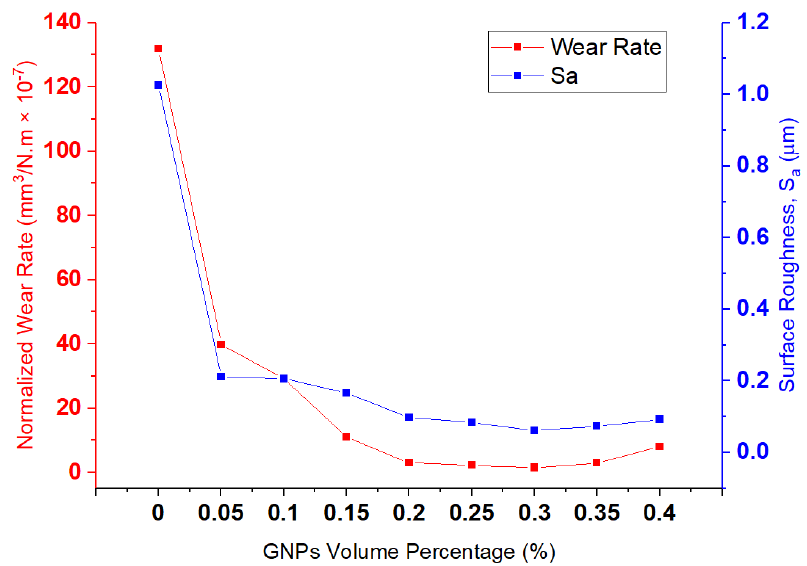
Figure 8. The relationship between wear rate, surface roughness (Sa), and GNPs concentration at 15 N.